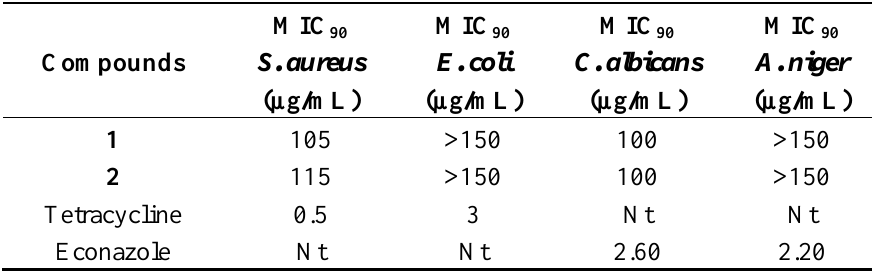
Table 2. Antimicrobial activities of 1 and 2